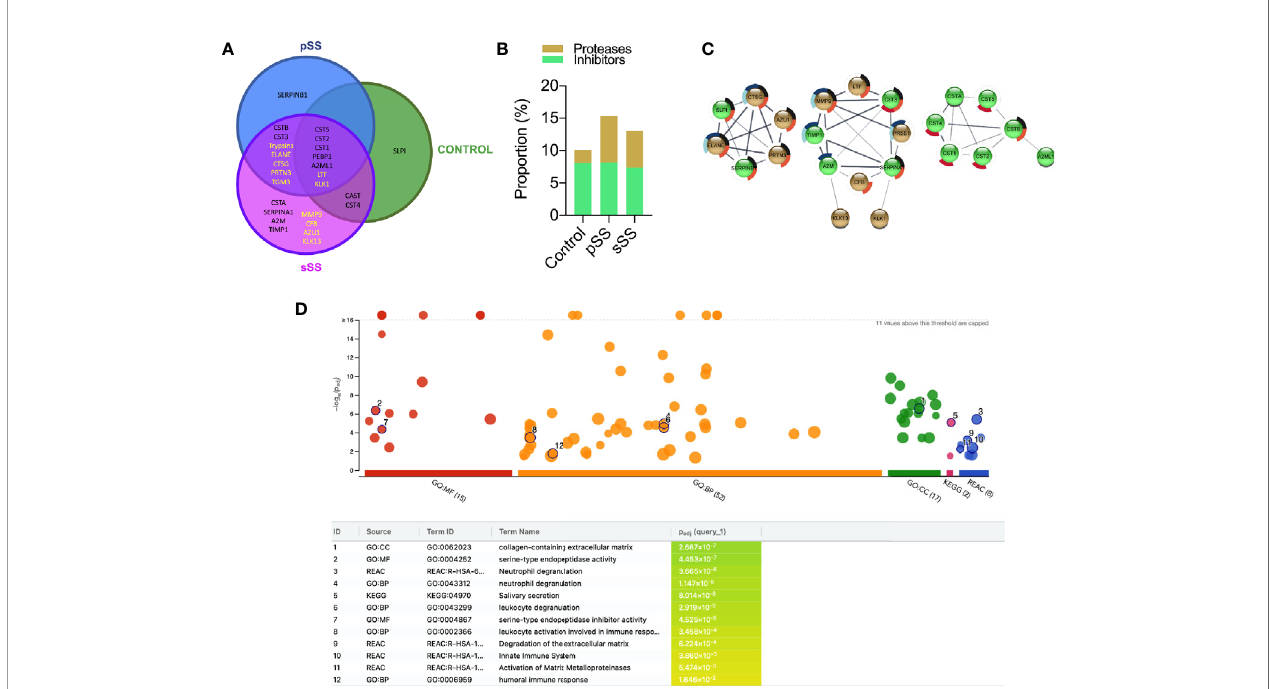
FIGURE 6 | Proteases and protease inhibitors identi fi ed in Sjögren ’ s syndrome saliva by LC-MS/MS. (A) Venn diagram for the proteases (yellow font) and protease inhibitors (black font) identi fi ed commonly or exclusively among the three groups. (B) Proportion of proteases and protease inhibitors identi fi ed in each comparison group. (C) Protein – protein interaction (PPI) analysis in STRING database. A con fi dence score of 0.4 was set as a cut-off allowing active interaction sources as evidence. Line thickness indicates the strength of data support. Brown: proteases. Green: protease inhibitors. Pie chart colors are related to the enrichment analysis performance by g:Pro fi ler. Black: neutrophil degranulation (GO.0043312); dark blue: degradation of the extracellular matrix (REAC:R-HSA-1474228); light blue: activation of matrix metalloproteinases (REAC:R-HSA-1592389); red: salivary secretion (KEGG:04970) and orange: immune response (GO:0006955). (D) g:Pro fi ler enrichment analysis plot. GO : MF (Molecular Function), GO : BP (Biological Process), GO : CC (Cellular Component), and KEGG Pathways. The number in the source name in the x-axis labels shows how many signi fi cantly enriched terms were found. Black circled numbers inside the plot are related to the ID column in the